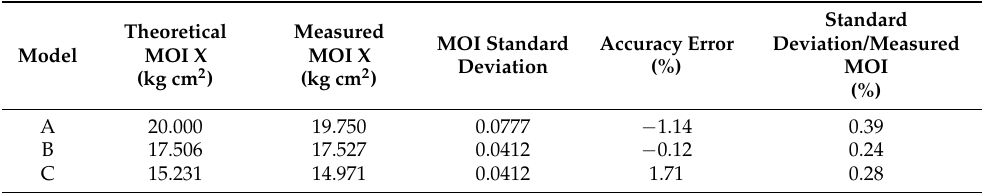
Table 5. Results summary of the references used to calibrate horizontal MOI test stand.